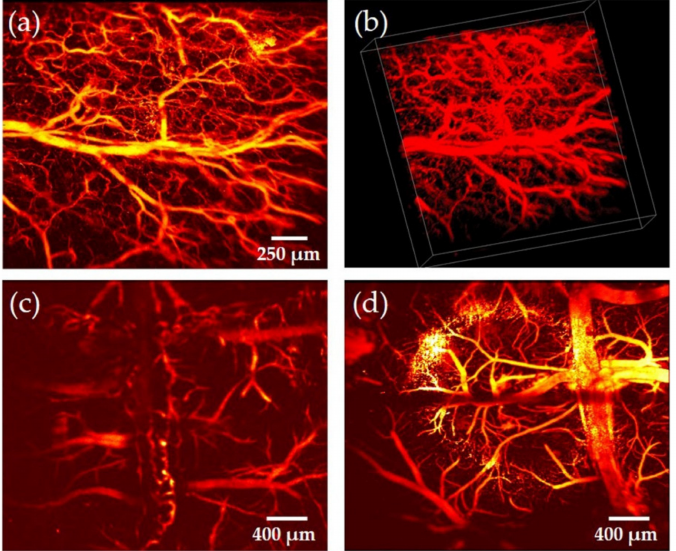
Figure 12. In vivo OR-PAM of the mouse ear and brain using the fiber laser sensor. ( a ) 2D MIP imaging of the mouse ear. ( b ) 3D volumetric image of the mouse ear, the white box is 2.2 × 2.2 × 0.52 mm. ( c ) In vivo imaging of the mouse brain with the skull. ( d ) In vivo imaging of the mouse brain without the skull. (a) and (b) adapted with permission from Ref.